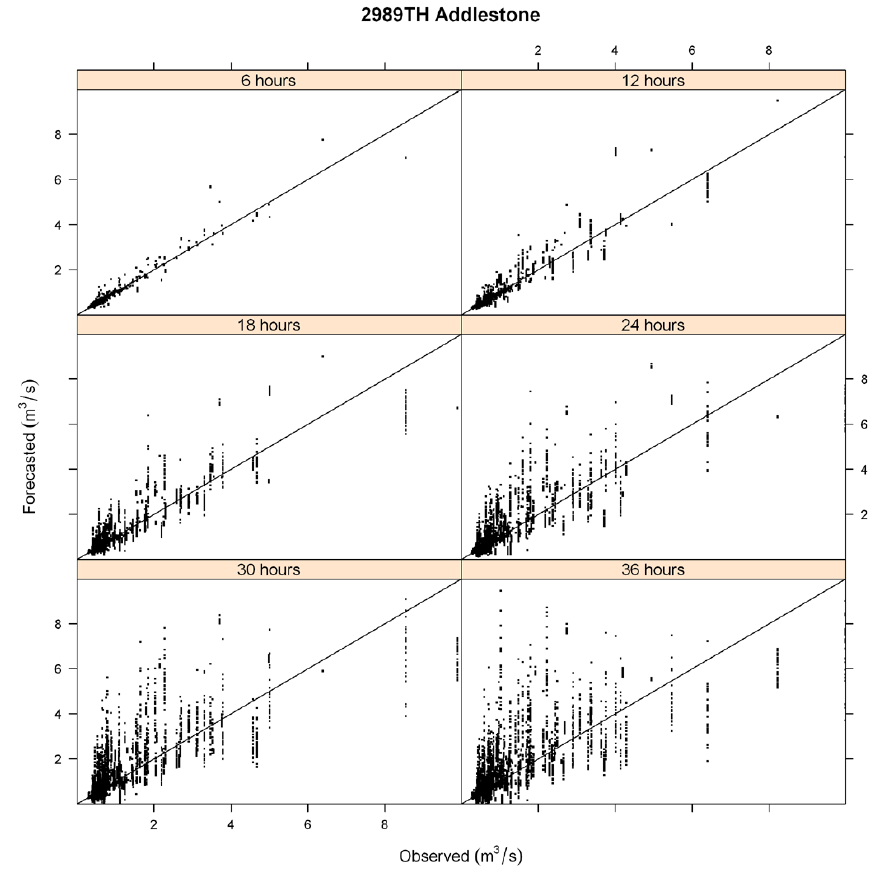
Fig. 2. Scatter plot of forecast and observed flow for different lead-times for Addlestone.